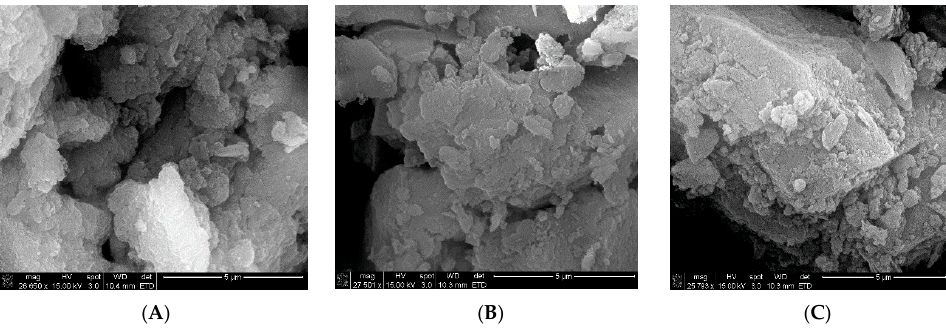
Figure 2. SEM images of OSU-6: ( A ) Fresh; ( B ) After three cycles; and ( C ) After five cycles.